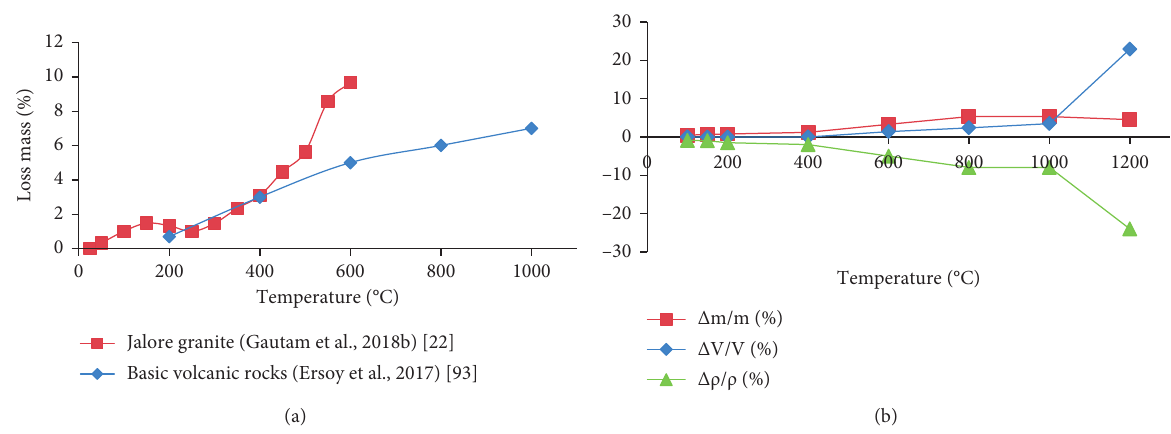
Figure 4: (a) Evolution of mass loss of basic volcanic rocks as a function of the temperature. (b) Change in volume, mass, and density of sandstone